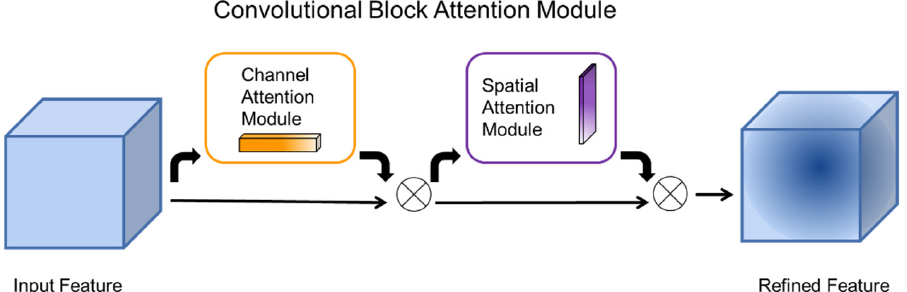
Figure 4. CBAM structure diagram.